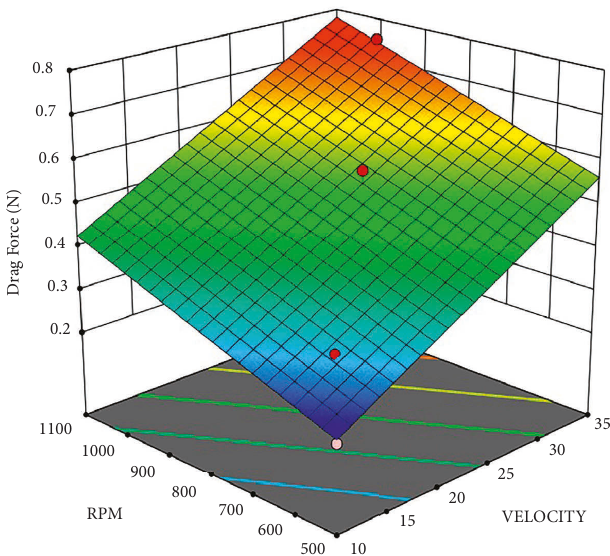
Figure 15: Drag force measured for the HH02